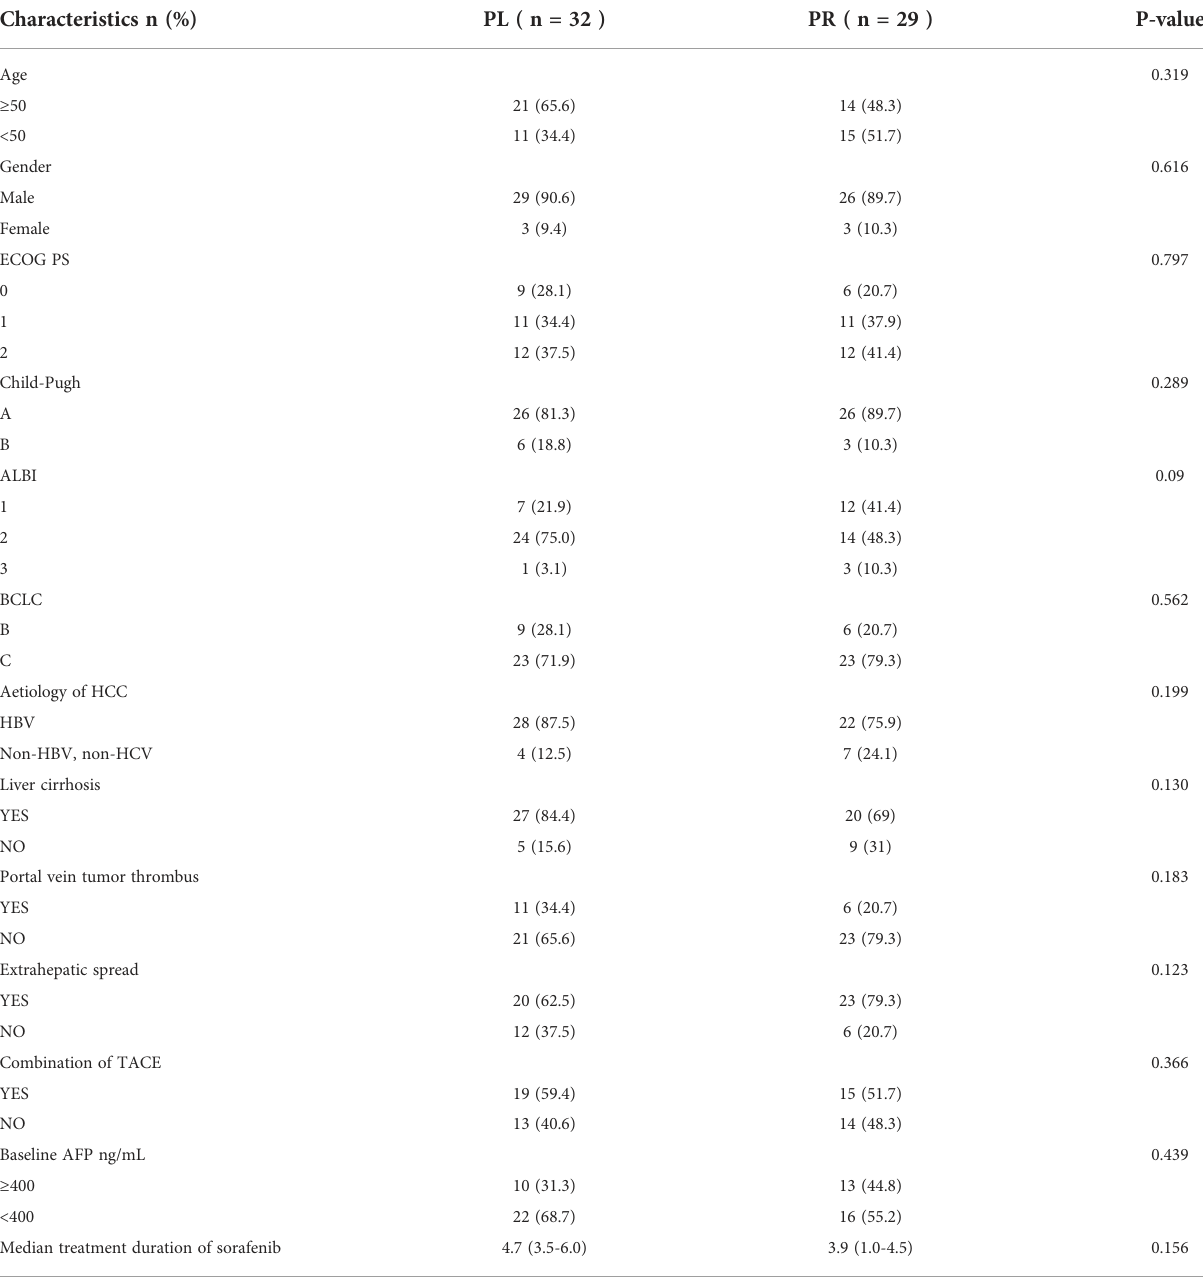
TABLE 1 Characteristics of patients in this